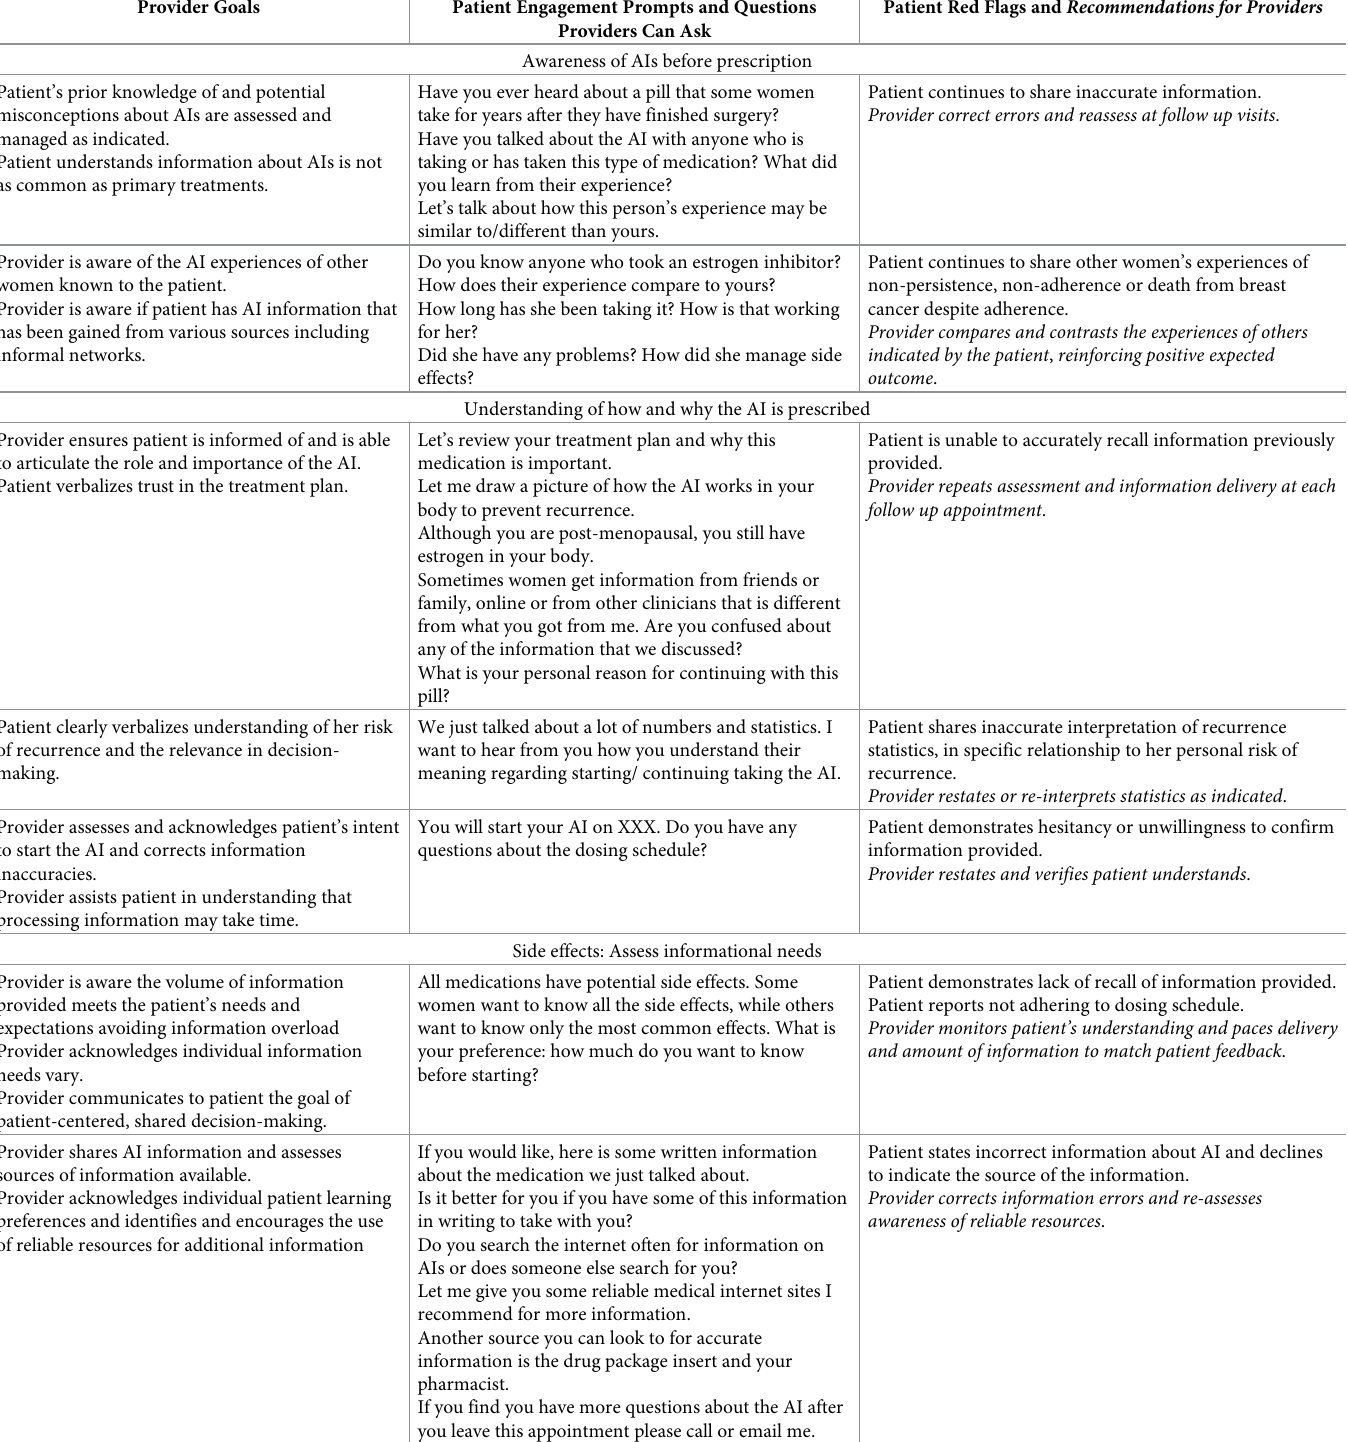
Table 5. Keys to guide provider communication with older women receiving an AI. Provider